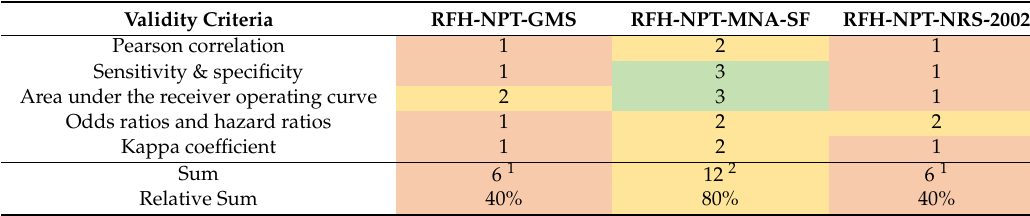
Table 4. Weighted results of screening